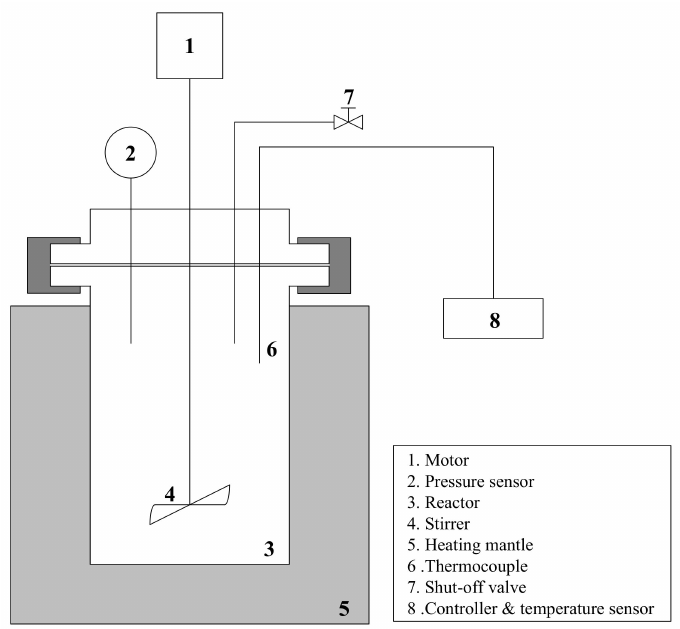
Figure 2. Schematic diagram of the hydrothermal carbonization experimental apparatus used in this study.